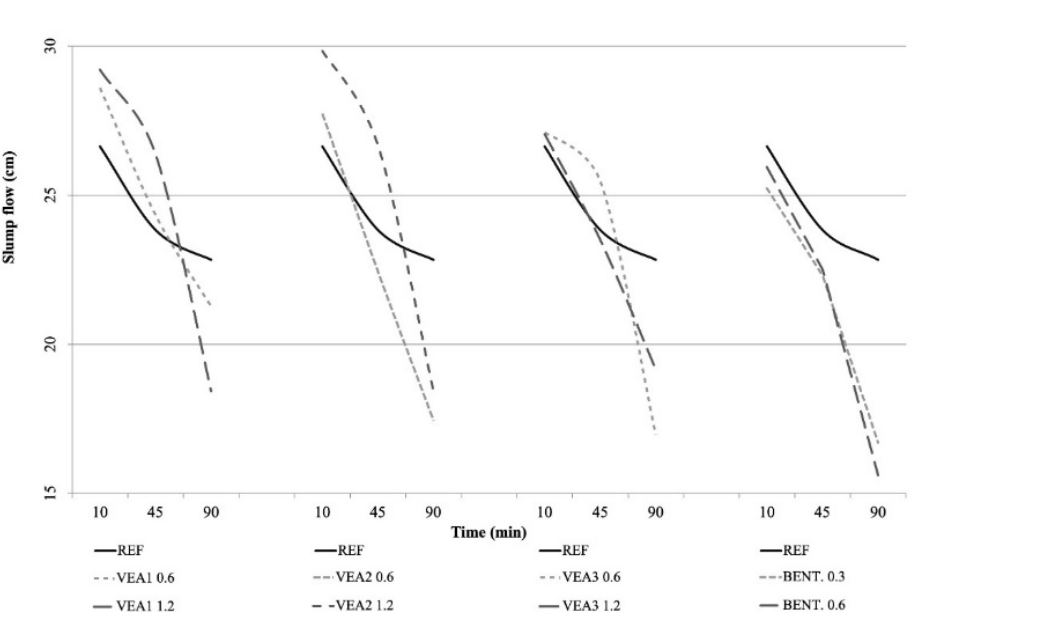
Figure 6. Consistency